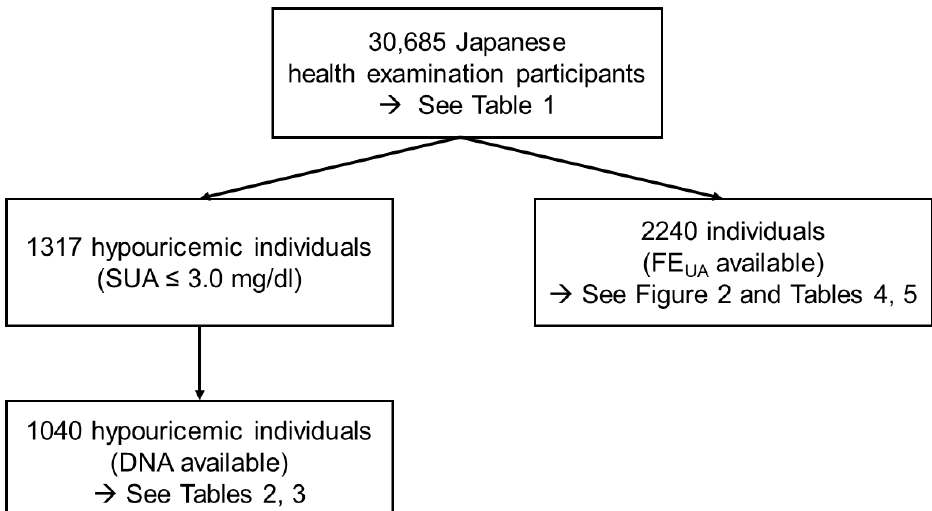
Figure 1. Selection of participants for each analysis. We first collected SUA data from 30,685 Japanese participants (13,607 males and 17,078 females) to gain an understanding of the distribution of SUA levels in the Japanese general population. Second, to investigate the frequency of NFV- URAT1 alleles, 1040 hypouricemic individuals (108 males and 932 females) with SUA of ≤ 3.0 mg/dL and whose genomic DNA samples were available were selected from 1317 hypouricemic individuals. Third,